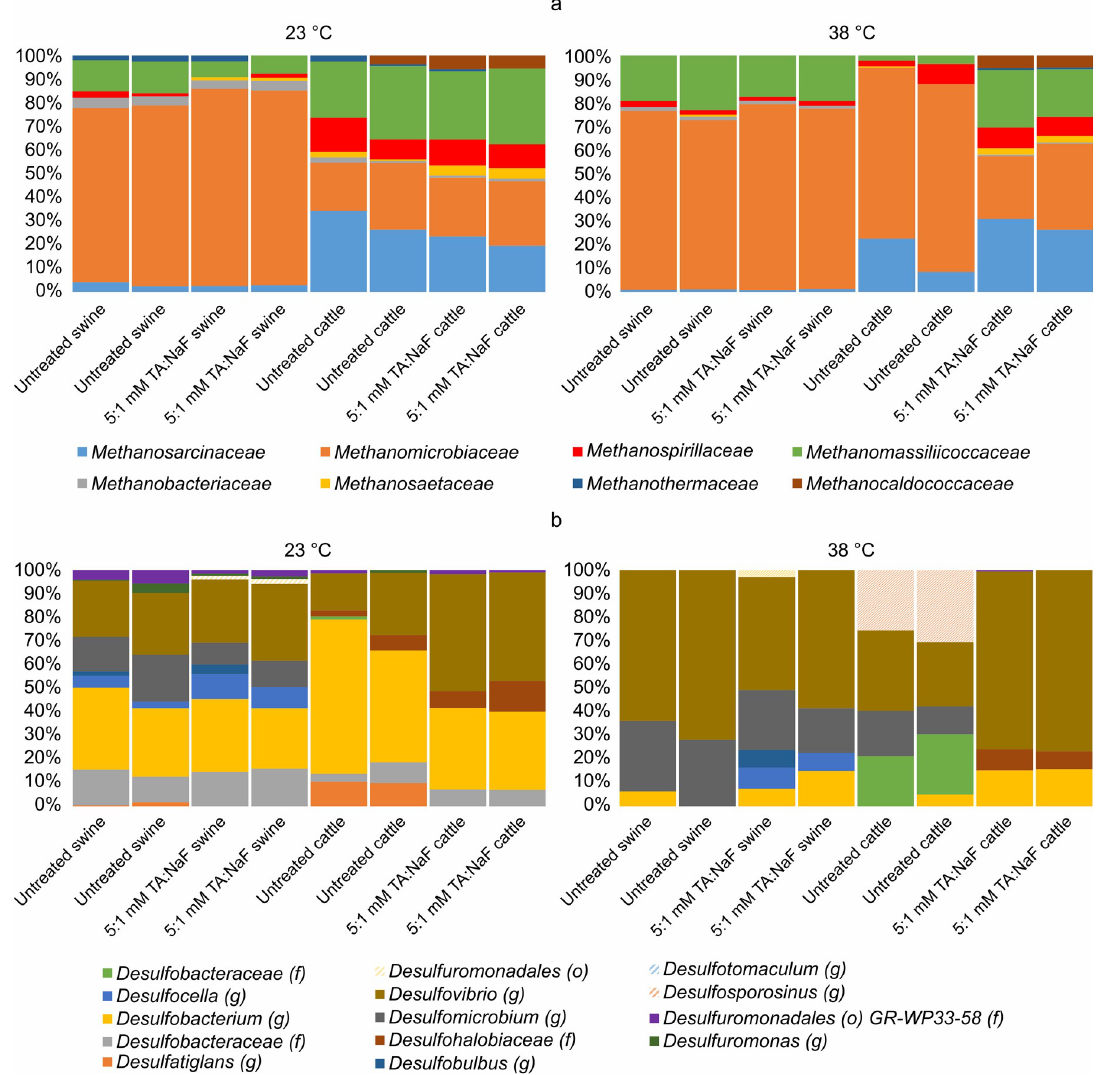
Fig 6. Relative abundance of methanogens at a family level in untreated and TA:NaF treated swine and cattle manure (a). Relative abundance of sulfate reducing bacteria (b), with taxonomic levels specified with (g) for genus, (f) for family, and (o) for order.